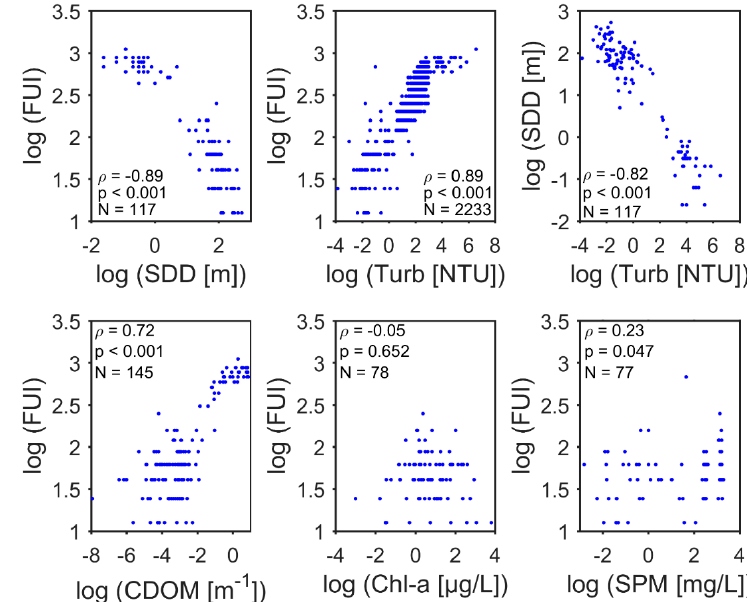
Figure 6. Spearman’s rank correlation test statistics from observed Forel-Ule Index (FUI), Secchi-disk depth (SDD), turbidity (Turb), coloured dissolved organic matter (CDOM), chlorophyll- a (chl- a ), and inorganic suspended particulate material (SPM). The statistics are correlation coefficients ( ρ ), number of points (N) and a statistical significance p -value.